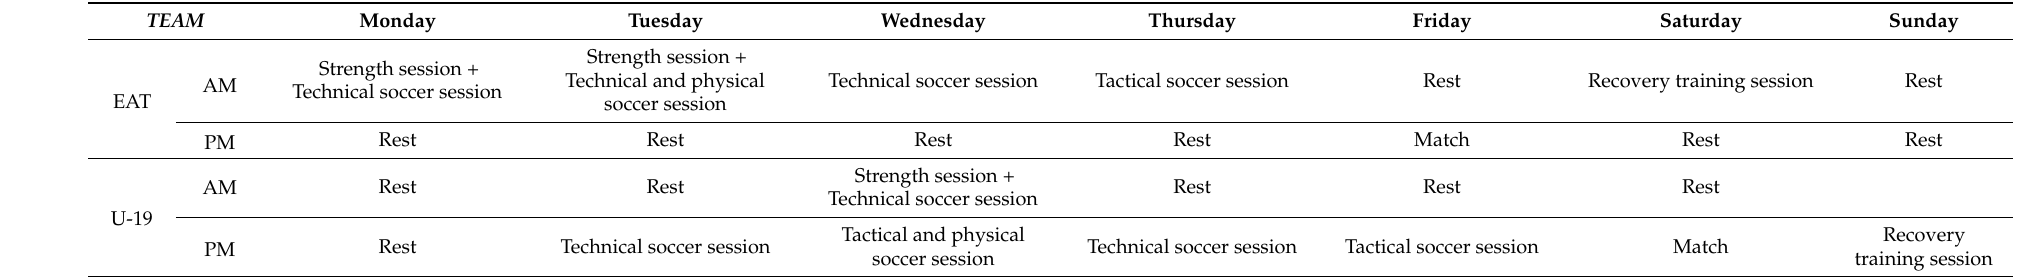
Table 1. Weekly training organization for both